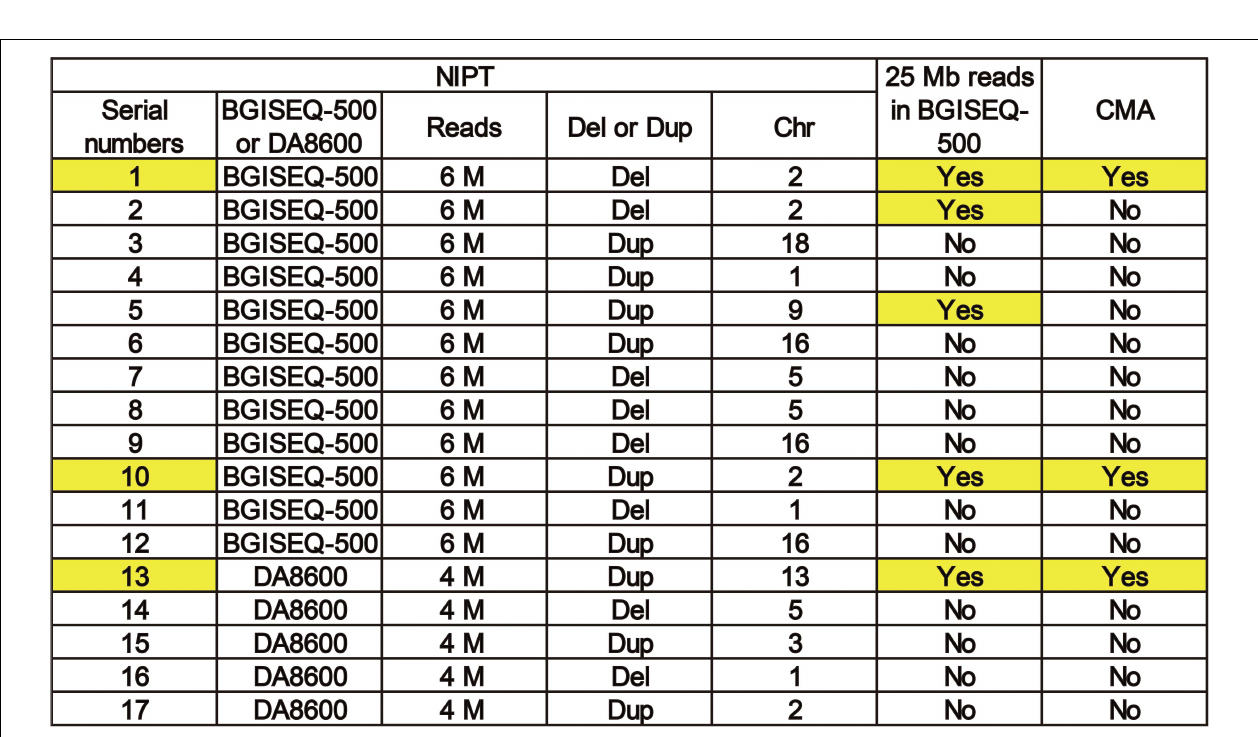
Frontiers in Molecular Biosciences |